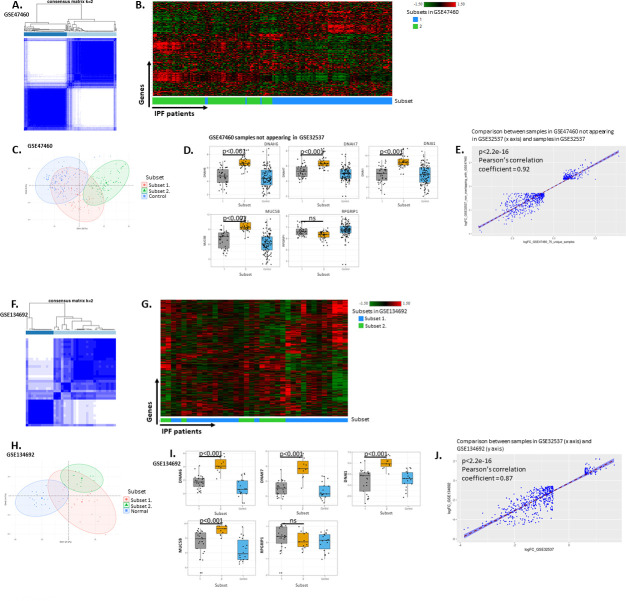
Consensus clustering results of cohort GSE47460 (Kaminski-LGRC bulk expression cohort) [14–17], GSE134692 (BMS bulk RNA-seq cohort) [18] and replication of GSE32537 (Schwartz-Univ of Colorado bulk expression cohort) [10] results.A. Consensus clustering of IPF patients in GSE47460 (Kaminski-LGRC bulk expression cohort) [14–17] based on the 5,000 most variable genes in IPF patients showing distribution of samples based on k = 2 consensus clusters. B. Hierarchical clustering of IPF samples from GSE47460 (Kaminski-LGRC bulk expression cohort) [14–17] using top 5,000 most variable genes. x axis represents individual patients, y axis represents genes. Subsets are indicated in x axis color bar and legend of heatmap and correspond to classes shown in Fig 1A. C. PCA of IPF and Control samples from GSE47460 (Kaminski-LGRC bulk expression cohort) [14–17] with IPF subsets and Control indicated. Subsets are indicated in legend of PCA plot and correspond to classes shown in Fig 1A. D. Expression of cilium-related genes previously identified by Yang et al. in [10] from the 75 samples in GSE47460 (Kaminski-LGRC bulk expression cohort) [14–17] not overlapping with GSE32537. Subsets are indicated on x axis of box plots and correspond to classes shown in Fig 1A. Adjusted p values determined by ANOVA and post-hoc Dunn’s test are reported on plots. E. Correlation plot of log fold changes calculated in GSE47460 (Kaminski-LGRC bulk expression cohort) [14–17] (when comparing Subset 1 and Subset 2 (x axis) using the 75 samples not appearing in GSE32537 and compared to GSE32537 (Schwartz-Univ of Colorado bulk expression cohort) [10] (y axis). Genes with reported absolute log fold change of larger than 0.58 and adjusted p value < 0.05 were used in this analysis from both datasets. F. Consensus clustering of IPF patients in GSE134692 (BMS bulk RNA-seq cohort) [18] based on the 5,000 most variable genes in IPF patients showing distribution of samples based on k = 2 consensus clusters. G. Hierarchical clustering of IPF samples from GSE134692 (BMS bulk RNA-seq cohort) [18] using top 5,000 most variable genes. x axis represents individual patients, y axis represents genes. Subsets are indicated in x axis color bar and legend of heatmap and correspond to classes shown in Fig 1F. H. PCA of IPF and Normal samples from GSE134692 (BMS bulk RNA-seq cohort) [18] with IPF subsets and Normal indicated. Subsets are indicated in legend of PCA plot and correspond to classes shown in Fig 1F. I. Expression of cilium-related genes from GSE134692 (BMS bulk RNA-seq cohort) [18] previously identified by Yang et al. [10]. Subsets are indicated on x axis of box plots and correspond to classes shown in Fig 1F. Adjusted p values determined by ANOVA and post-hoc Dunn’s test are reported on plots. J. Correlation plot of log fold changes calculated in GSE32537 (Schwartz-Univ of Colorado bulk expression cohort) [10] (when comparing Subset 1 and Subset 2 (x axis, logFC_GSE32537) compared to GSE134692 (BMS bulk RNA-seq cohort) [18] subsets (y axis, logFC_GSE134692). Genes with reported absolute log fold change of larger than 0.58 and adjusted p value < 0.05 were used in this analysis from both datasets.